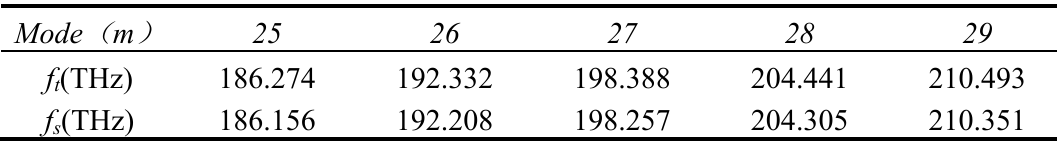
Table 2. Comparison of the theoretical resonant frequency ( f frequency ( f ) of the microring for mode 25, 26, 27, 28 and s